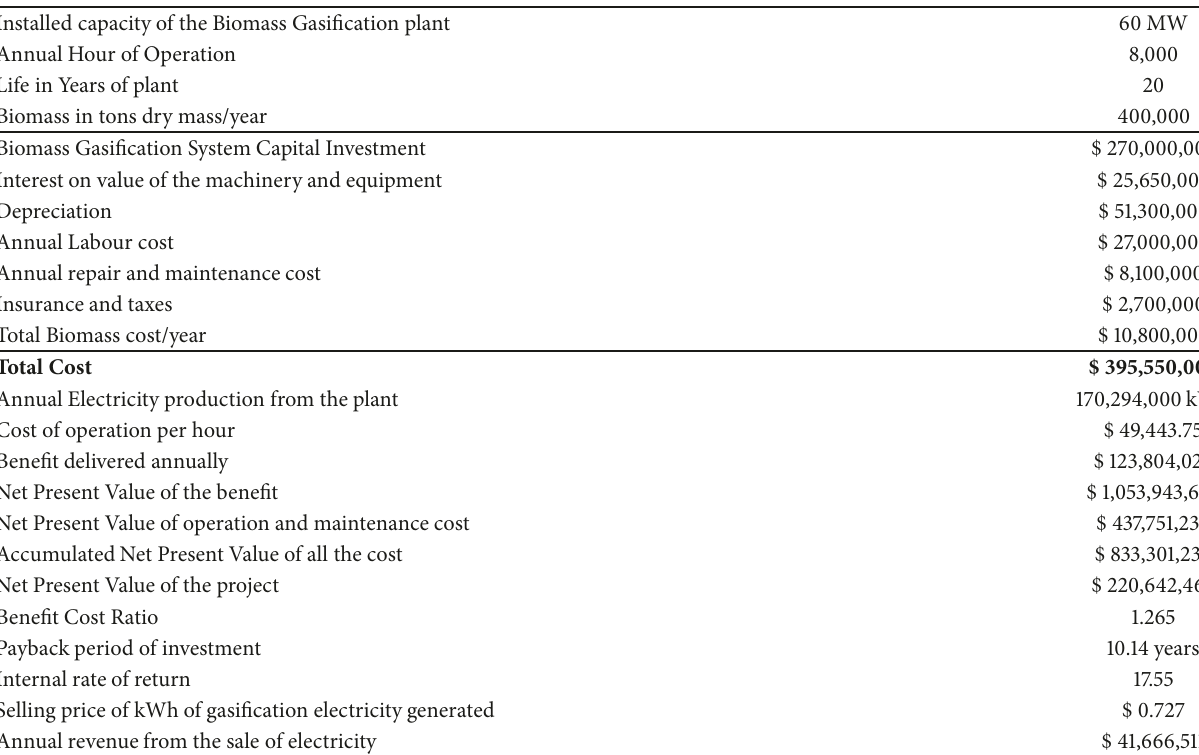
Table 18: Estimated cost structure of biomass gasification